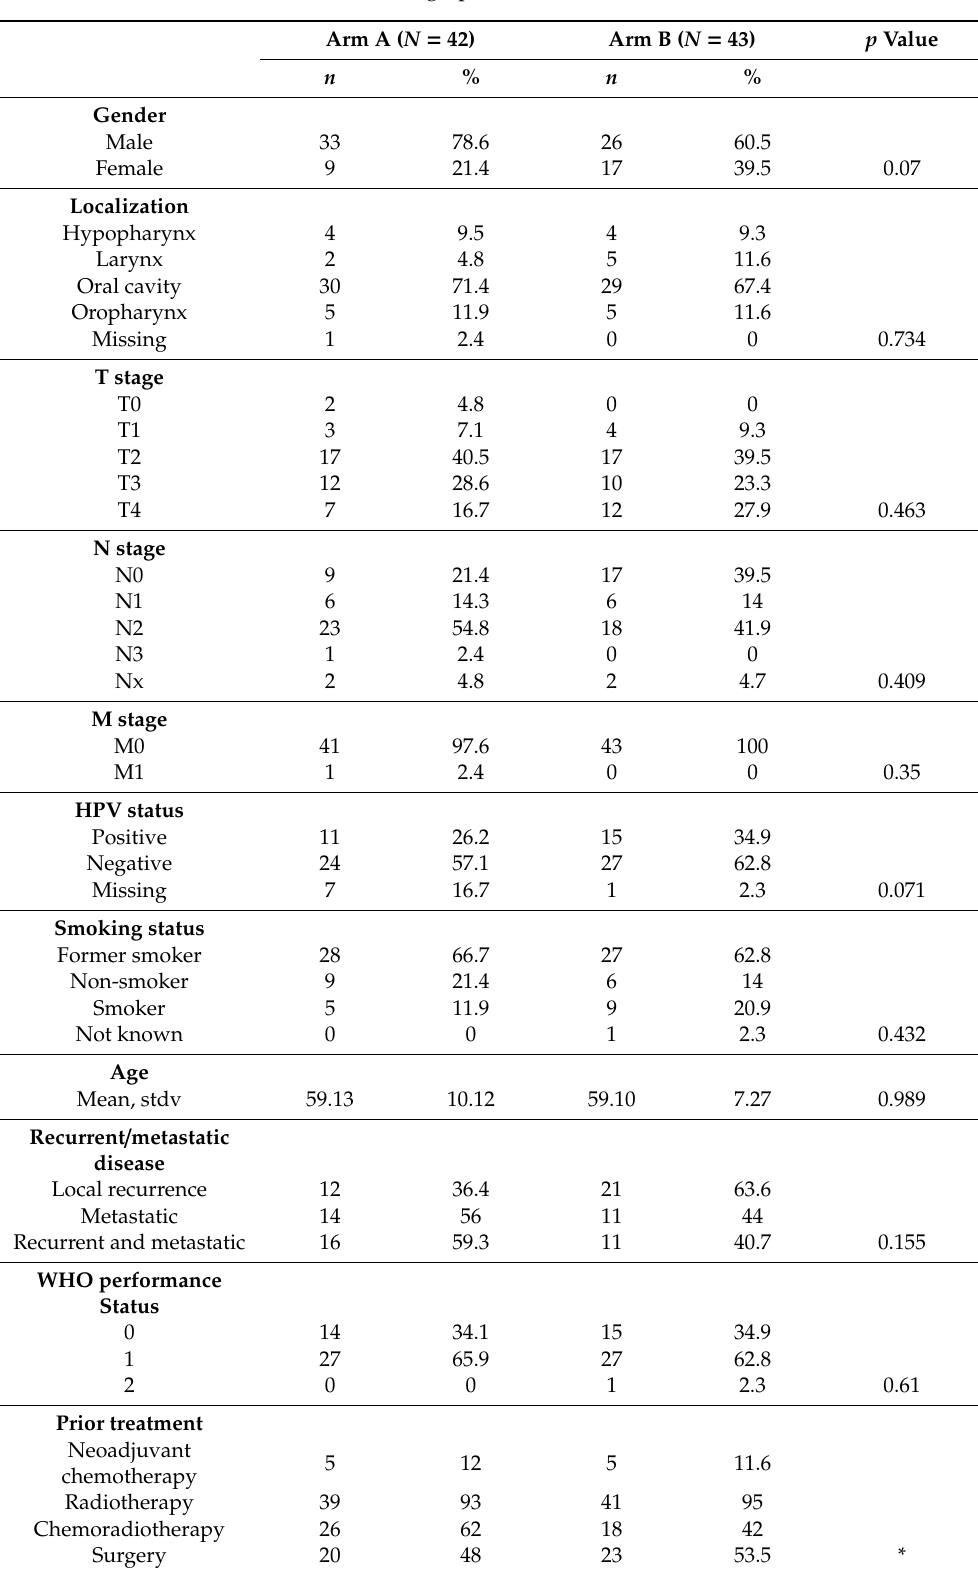
Table 1. Baseline demographics and disease